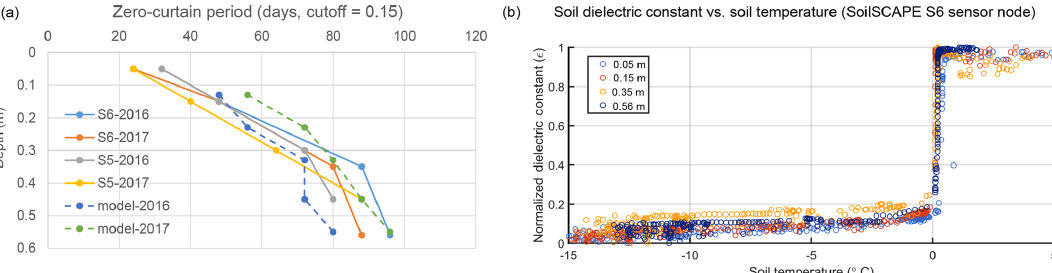
Figure 4. Soil-freezing characteristics at the Prudhoe Meadow SoilSCAPE site: (a) comparisons of modeled and observed zero-curtain period at two sensor nodes (S5 and S6) using a cutoff threshold of 0.15 (Eq. 12) for both in situ soil dielectric constant and model-simulated unfrozen water content to determine soil freeze onset; (b) changes in in situ soil dielectric constant during soil freezing at the S6 node. The soil dielectric constant was normalized using the maximum and minimum values of soil dielectric constant during the observation period.